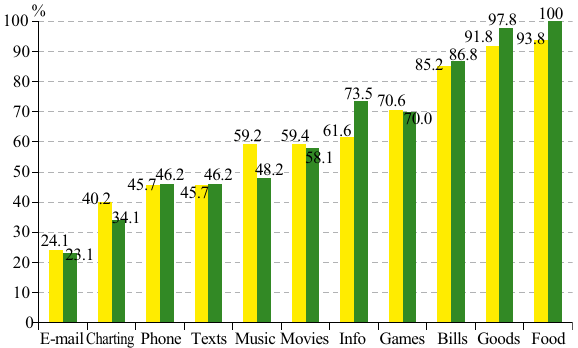
Fig. 9. Whether virtual activity replaced or not a physical trip ( – respondents living off the campus; – respondens living in the campus)? Total sample using each mode, %